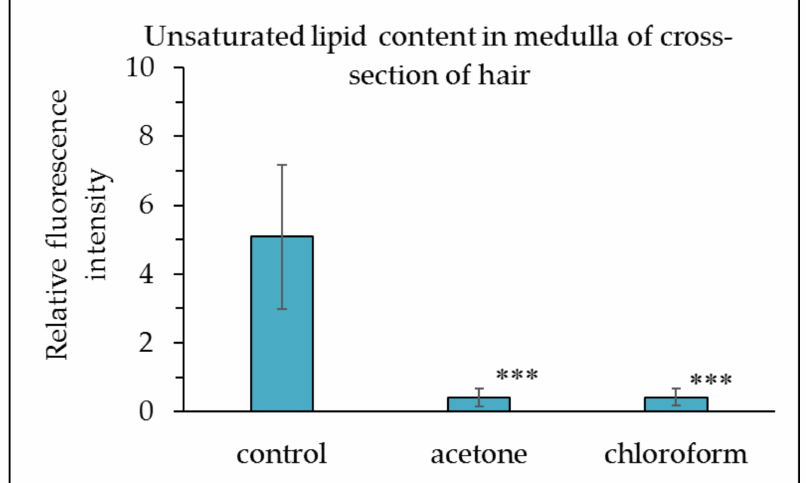
Figure 4. Unsaturated lipid content in medulla of the hair cross-section following lipid content reduction by an acetone or chloroform treatment. The results are expressed as the mean ± standard deviation from 10 experiments. ∗∗∗ p < 0.001 vs. control.